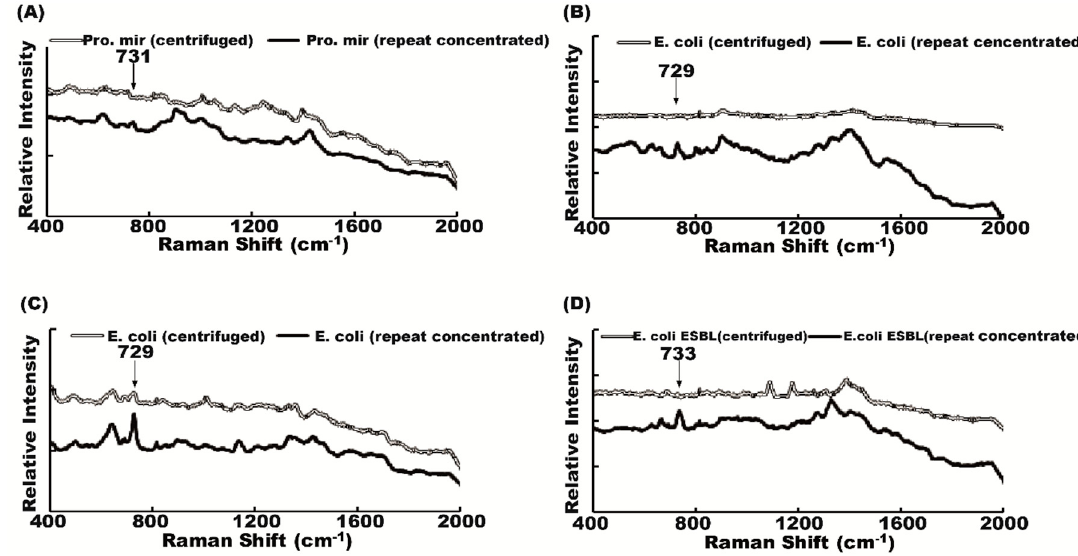
Figure 3. Centrifuged method and repeat concentrated method. Urinary-tract-infection (UTI) pathogens in the four samples that failed to be identified by the centrifugation method because of low resolution could be recognized with the repeat concentrated method. ( A ) Proteus mirabilis ; ( B , C ) E. coli ; and ( D ) E. coli ESBL .